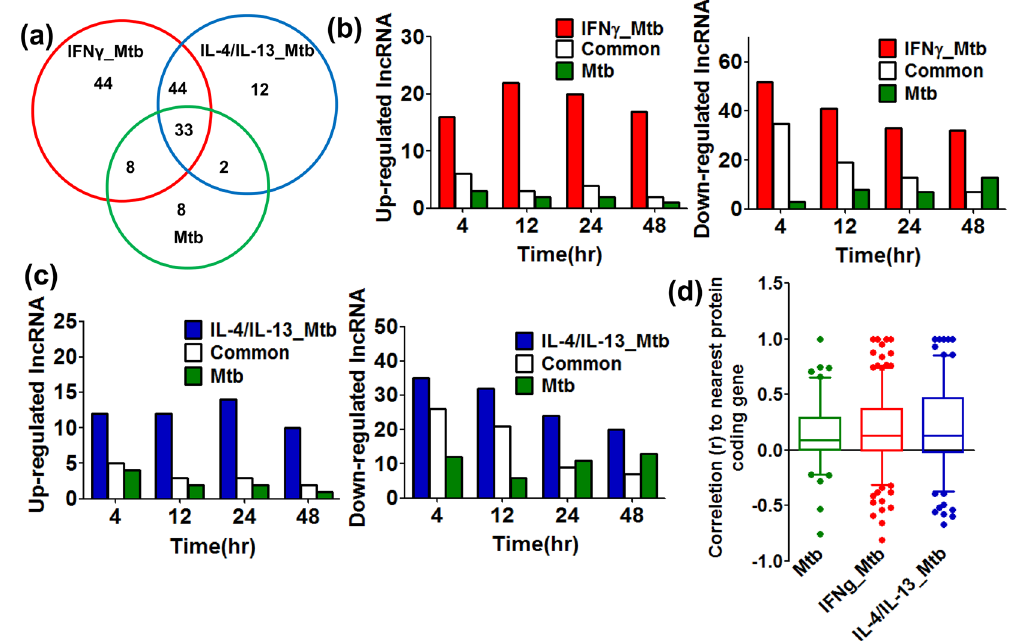
Figure 6. Differentially expressed lncRNAs in Mtb infected macrophages shows unique transcriptional features. ( a ) Venn diagram analysis of differentially expressed lncRNAs in Mtb, IFN γ _Mtb and IL-4/IL-13_Mtb. The overall landscape of differentially expressed (up and down) genes regardless of time was shown. ( b ) Number of up-regulated (left panel) and down-regulated (right panel) lncRNAs at each time point in Mtb and IFN γ _Mtb. Open column indicates commonly regulated lncRNAs and red and green column indicate specifically regulated lncRNAs in IFN γ _Mtb and Mtb, respectively. (c) Number of up-regulated (left panel) and down-regulated (right panel) lncRNAs at each time point in Mtb andIL-4/IL-13_Mtb. Open column indicates commonly regulated lncRNAs and blue and green column indicate specifically regulated lncRNAs in IL-4/ IL-13_Mtb and Mtb, respectively. (d ) Expression correlation between differentially expressed lncRNAs and their nearest protein coding genes. Boxes show median and interquartile ranges and whiskers show the 10 th and 90 th percentile